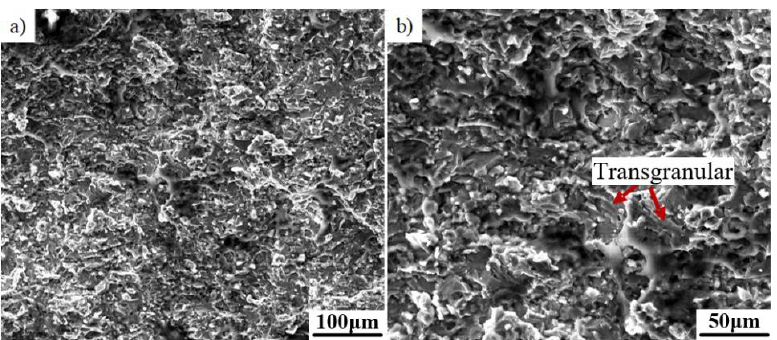
Figure 7. The fracture surface for the bending sample of the as-forged TiAl alloy. ( a ) macro morphology, ( b ) transgranular feature. ogy, ( b ) transgranular feature.